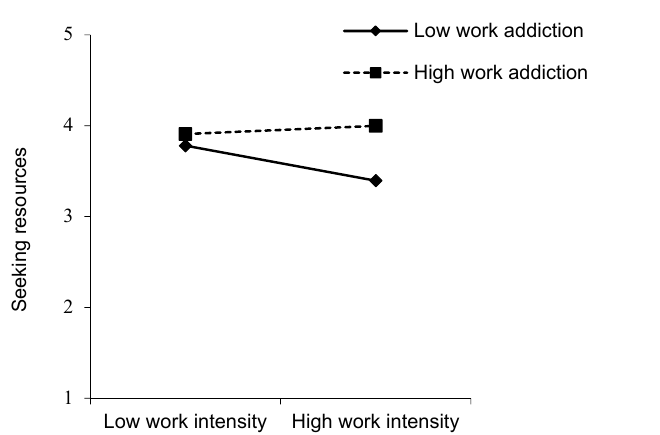
Figure 2. The interaction of work intensification and work addiction on seeking resources.